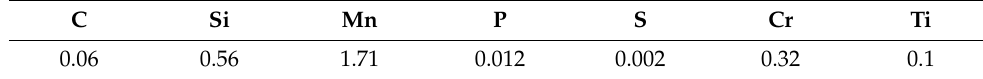
Table 1. Chemical compositions of the three steel plates (wt.%).